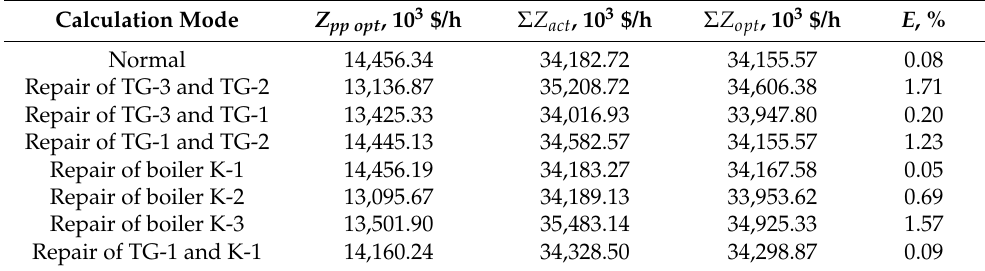
Table 10. Estimate of the Efficiency of Implementing the Study